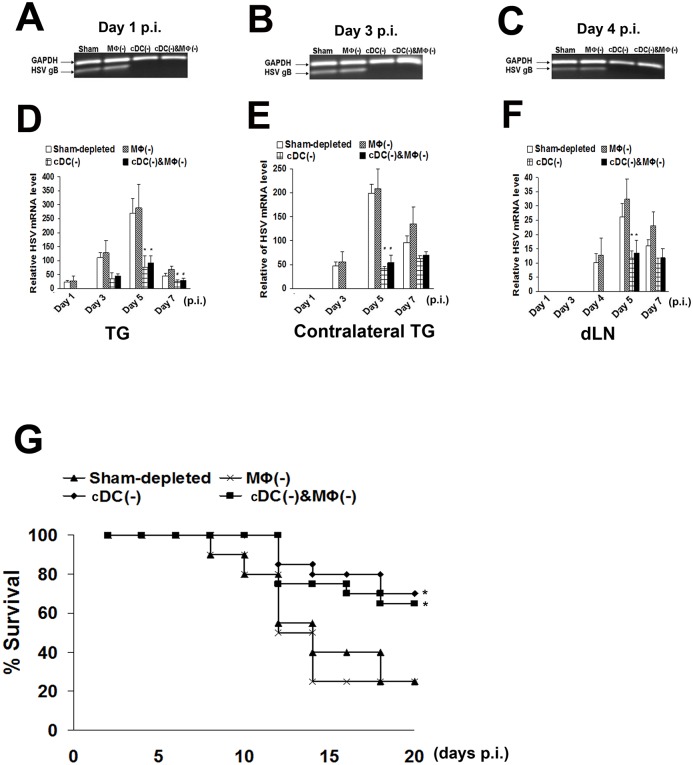
Corneal conventional dendritic cell depletion results in delayed and decreased systemic viral transmission and subsequent increase in survival rate after corneal HSV-1 infection.After corneal HSV-1 infection, trigeminal ganglions (TGs) or draining lymph nodes (dLNs) (n = 6/time point) were collected and HSV-1 mRNA levels were measured. The survival rates of infected mice were monitored (n = 20). A, D: On day 1 p.i, HSV mRNA was detected in the TGs of sham-depleted or MΦ-depleted mice, but not in cDC-depleted (single or double-depleted with MΦ) mice. Viral mRNA was detected on day 3 p.i. in the TGs of mice with corneal cDC-depletion, but was significantly lower as compared to sham-depleted and MΦ-depleted mice. B, E: On day 4 p.i, viral mRNA was detected in dLNs of sham-depleted or MΦ-depleted mice, but not in mice with corneal cDC-depletion. However, on day 5 p.i., viral mRNA was detected in dLNs of mice with corneal cDC-depletion, but at significantly lower levels than in sham-depleted controls. C, F: HSV mRNA was also detected in the contralateral TGs with 2 days delay, and corneal cDC-depletion resulted in delayed and decreased virus levels. G: Survival rates of mice with corneal cDC-depletion or mice with corneal cDC/MΦ double-depletion were significantly increased as compared to sham-depleted mice, or MΦ-depleted mice. Each experiment, including the survival experiments, was replicated three times. *p<0.05, #
p<0.01 compared with sham-depleted corneas (ANOVA-D, E, F, two-sided; Fisher Exact Probability Test-G). Data are shown as mean ± SD.